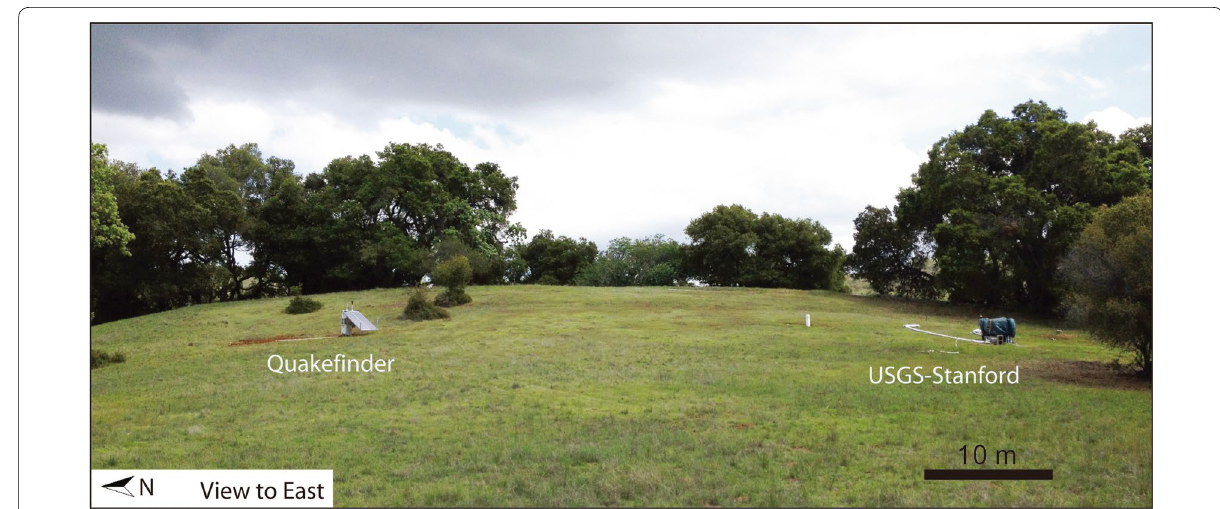
Fig. 2 Photograph of QuakeFinder temporary installation (left, north) and USGS-Stanford permanent electromagnetic observatory JRSC (right,